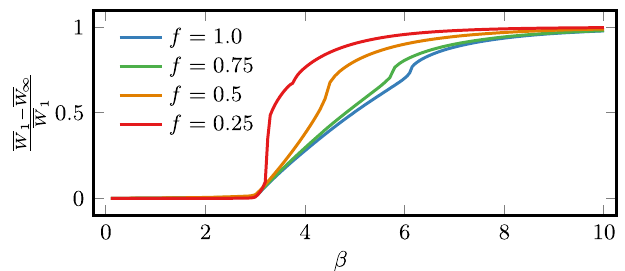
FIG. 11. Comparisonbetweenstationarysingle-unitworkcurrent ¯ W 1 and asymptotic MF work current f ¼ 0 . 25 , 0.5, 0.75, 1.0. The time t ¼ 500 is chosen such that the time-averaged MF work has converged to its asymptotic